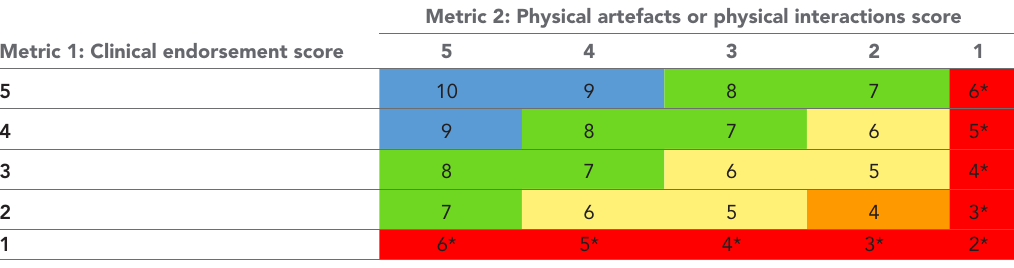
Table 2 Translatability to telehealth score interpretation. A non- colour dependent version of this table is available in the supplementary materials.